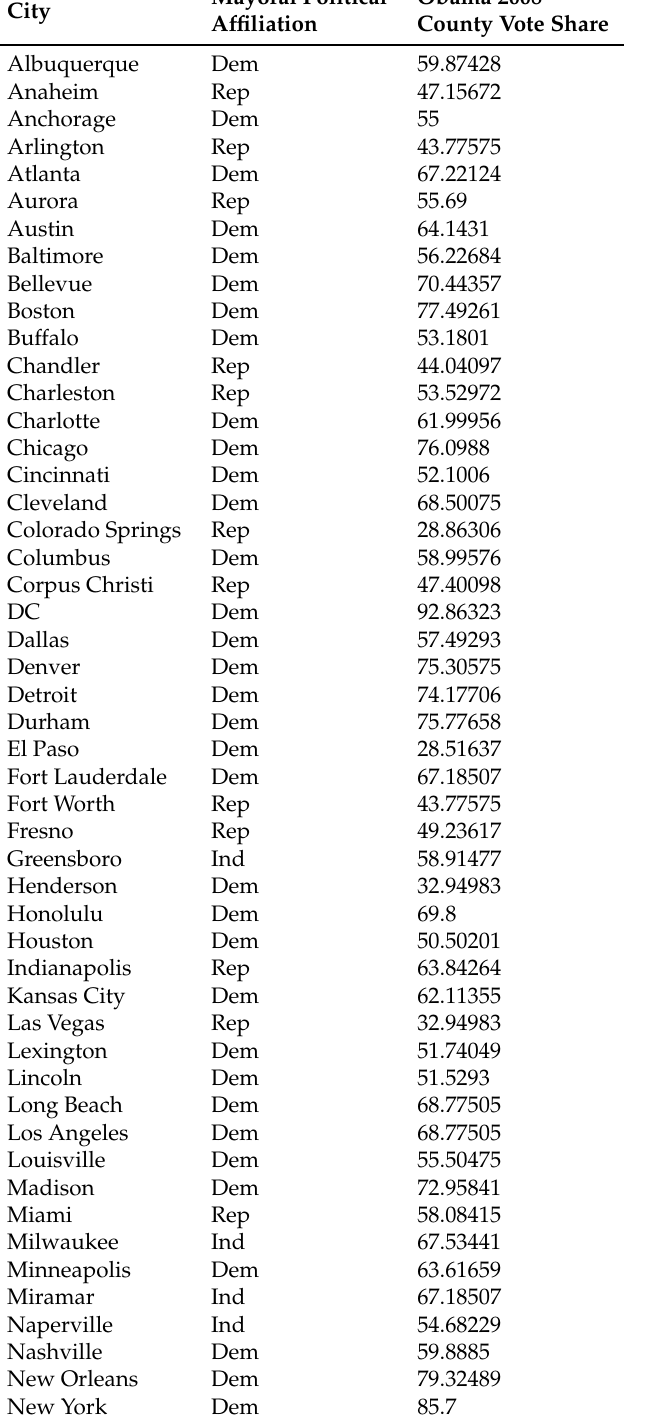
Table A6. This table displays mayoral political affiliation and the county-level vote share for Barack Obama in the 2008 US presidential